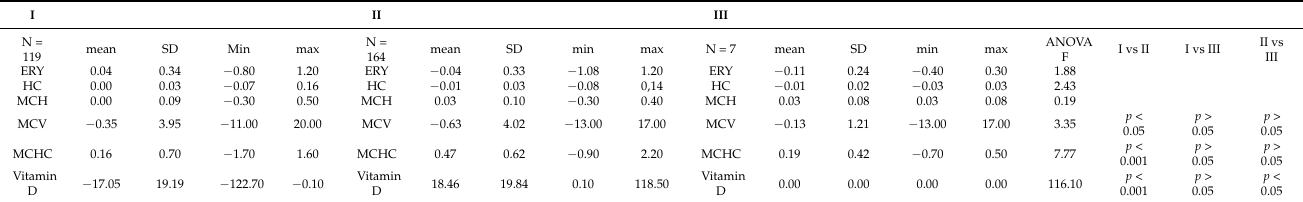
Table 2. Comparison between groups I, II, III.